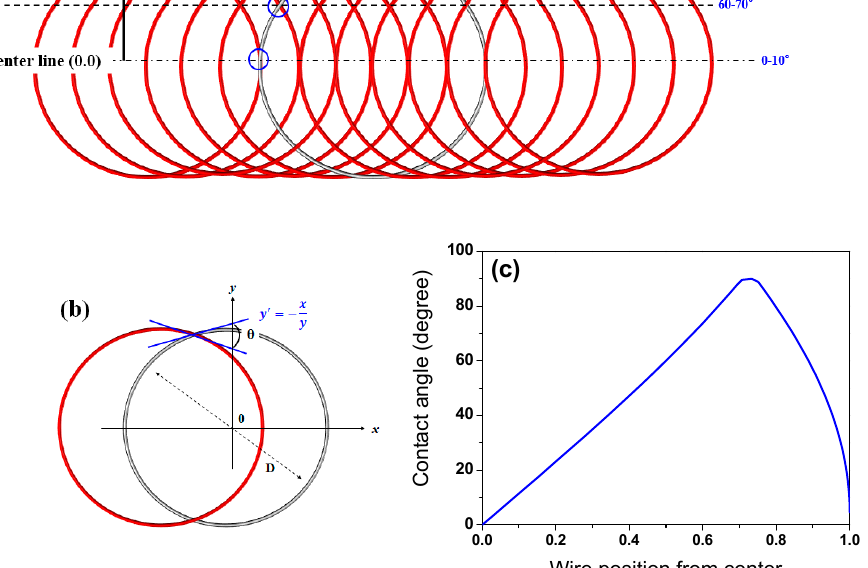
Figure 14. Calculated ( a ) projection area of wire ring with wire position and ( b ) hotspot indicator as a function of wire diameter and wire position during Stelmor cooling. 4.3. Effect of Ring Pitch and Solutions for Improving Uniformity in Wire Ring P wr affects both the WPD and contact point of the wire ring as depicted in Figure 15. The number of contact points per wire ring ( N cp ) was calculated as follows: 𝑁 (cid:3030)(cid:3043) = 3.9(cid:3436) 𝐷 𝑃 (cid:3050)(cid:3045) (cid:3440)